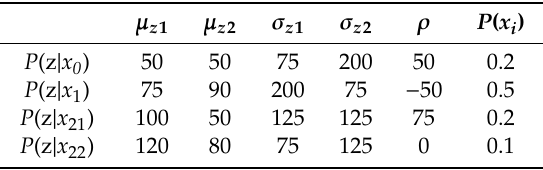
Table 3. The parameters of four Gaussian distributions.